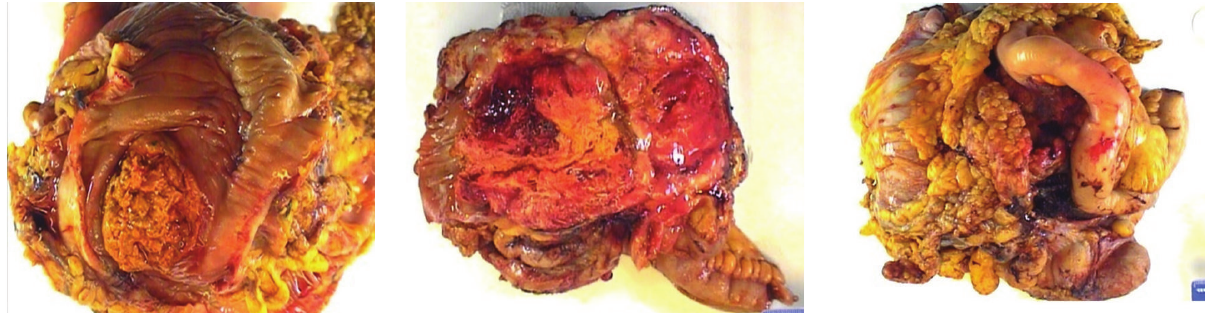
Figure 3: Surgical specimen showing resected mesenteric mass, fistularizing into the colon and right hemicolectomy.